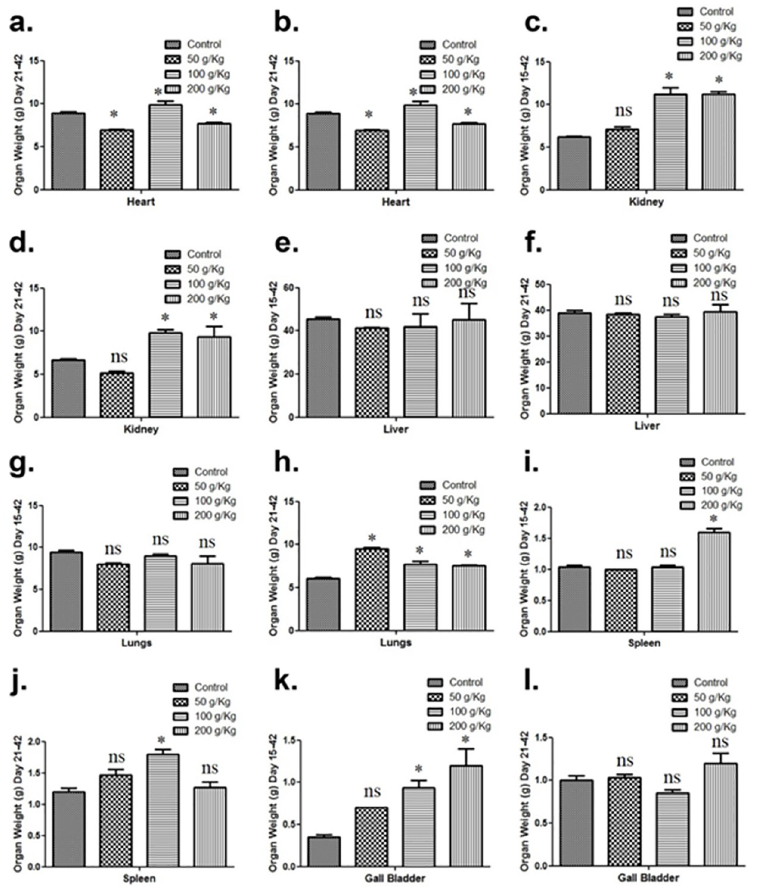
Fig 2. Graphs showing the carcass characteristics of broiler by comparison of various body organ weight of different quinoa enriched diet given chicken groups fed from days 15 to 42 and from days 21 to 42 post-birth. The chickens were given 50 g/Kg, 100 g/Kg and 200 g/Kg of quinoa. ( a ). Heart (Days 15–42) ( b ). Heart (Days 21–42) ( c ). Kidney (Days 15–42) ( d ). Kidney (Days 21–42) ( e ). Liver (Days 15–42) ( f ). Liver (Days 21–42) ( g ). Lungs (Days 15–42) ( h ). Lungs (Days 21–42) ( i ). Spleen (Days 15–42) ( j ). Spleen (Days 21–42) ( k ). Gall bladder (Days 15–42) ( l ). Gall bladder (Days 21–42). All data are expressed as means ± standard deviation (SD) from measurements on 15